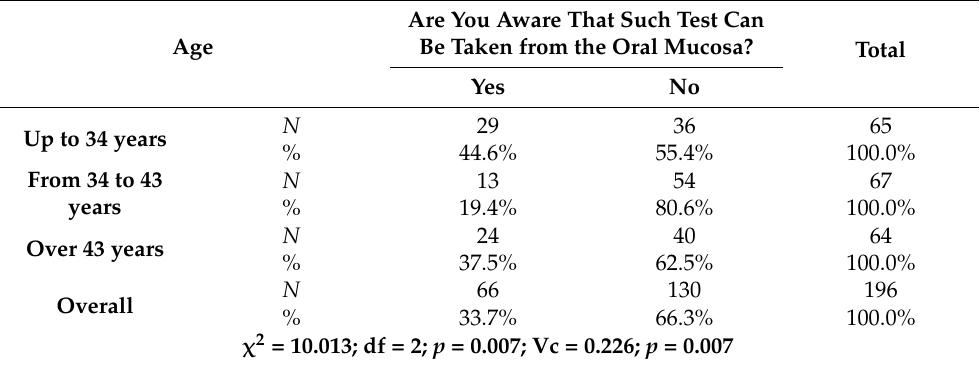
Table 7. Results from analyzing the relationship between the age of the respondents and the awareness that HPV test can be taken from the oral mucosa. Are You Aware That Such Test Can Age Be Taken from the Oral Mucosa? Total Yes No N 29 36 65 Up to 34 years % 44.6% 55.4% 100.0% From 34 to 43 N 13 54 years % 19.4% 80.6% 100.0% 37.5%